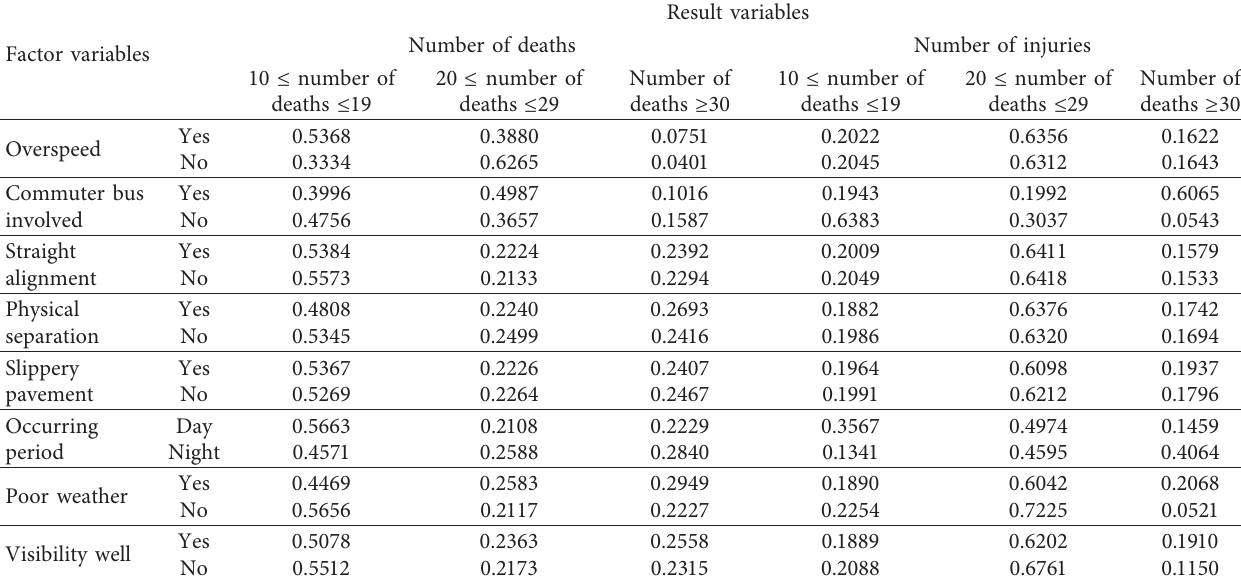
Table 6: The conditional probability of the number of deaths for the single-vehicle traffic accident.